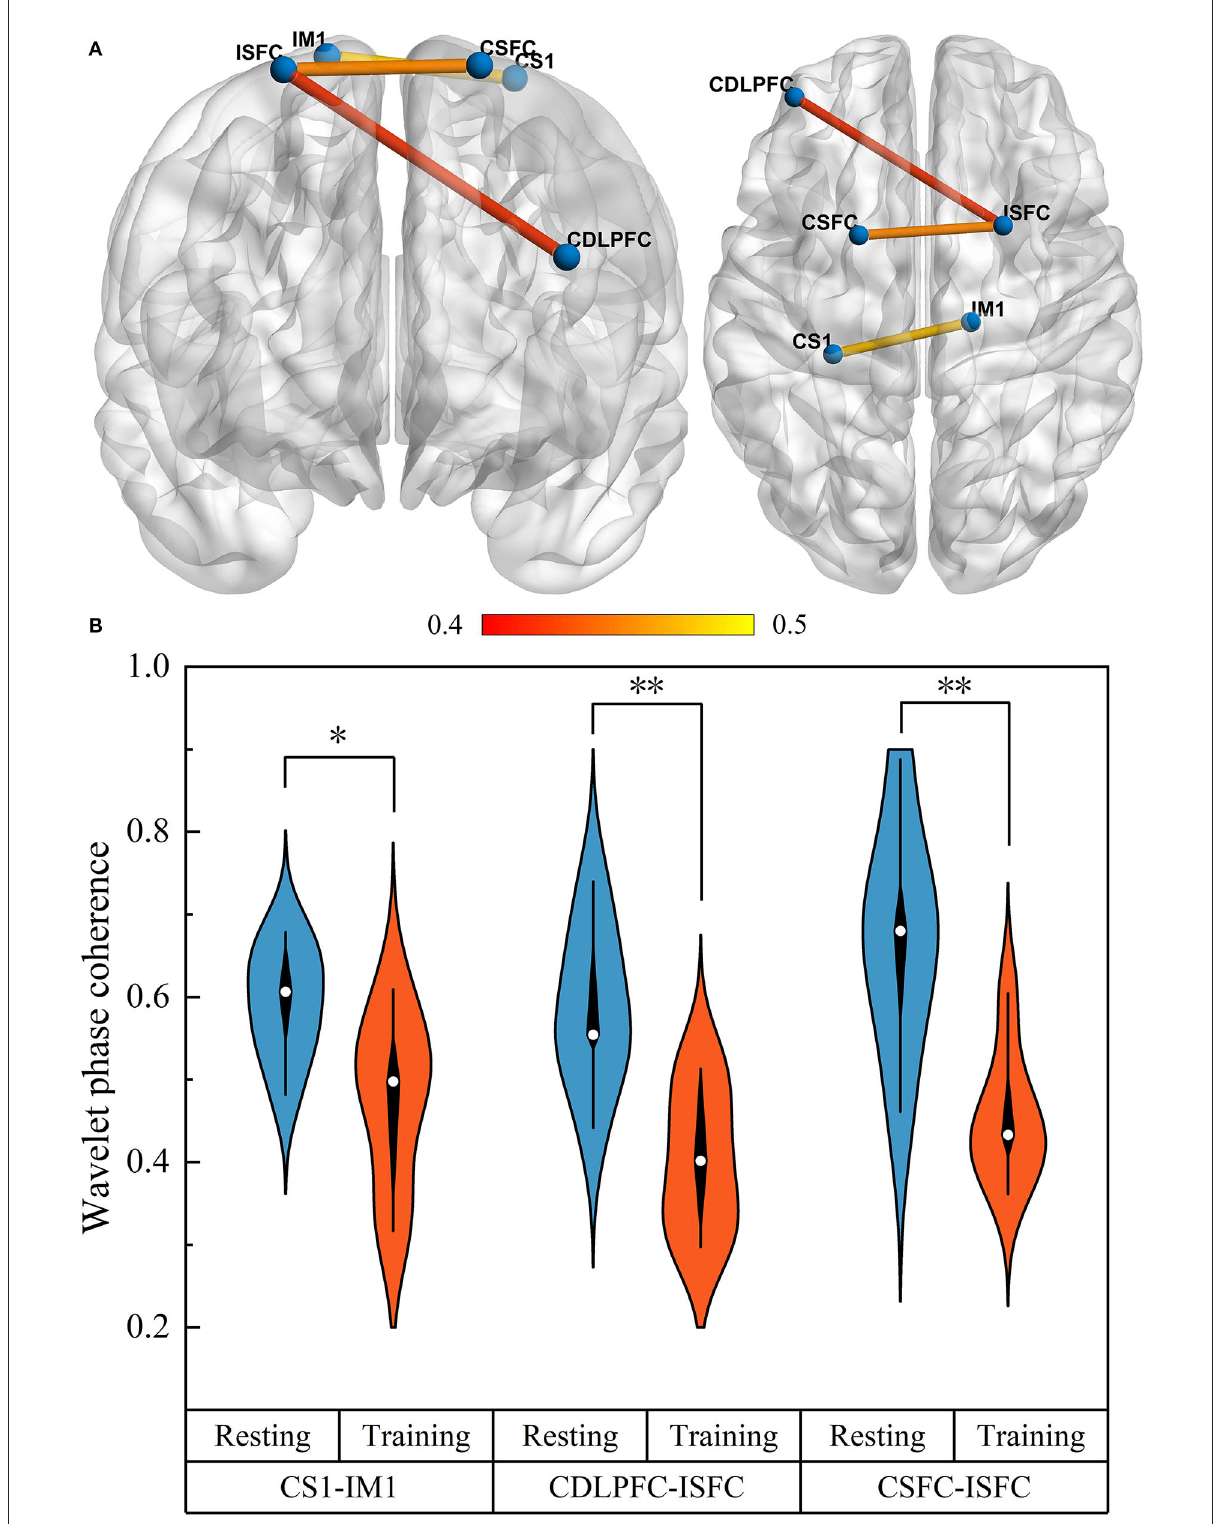
FIGURE5 The functional connectivity visual map (A) . The connectivity line indicates a significant WPCO value between the two regions. Line color indicates the connectivity intensity, and the brighter color represents higher strength. The result of significant changes of WPCO values in motor training compared with resting state (B) (* p < 0.05; ** p <